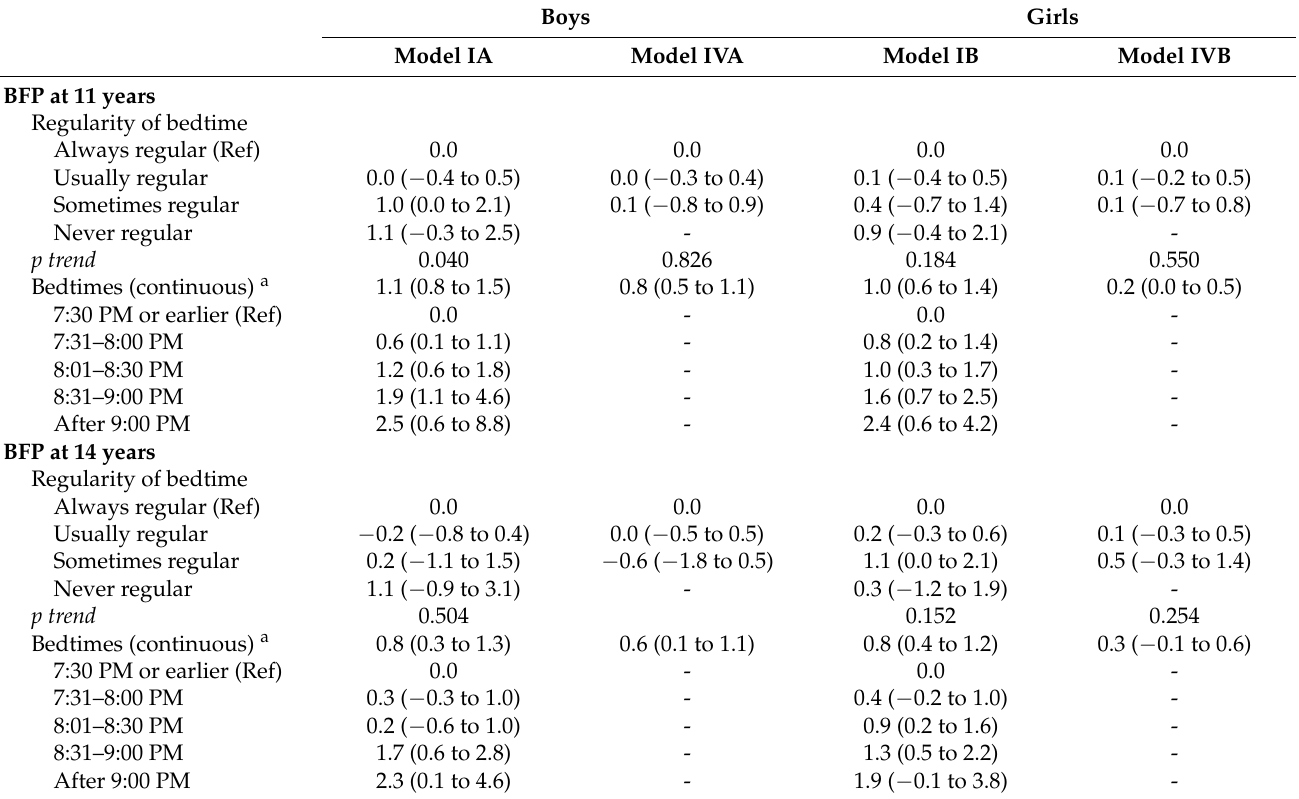
Table 3. Associations between bedtime regularity and bedtimes at 7 years and BFP at 11 and 14 years among boys and